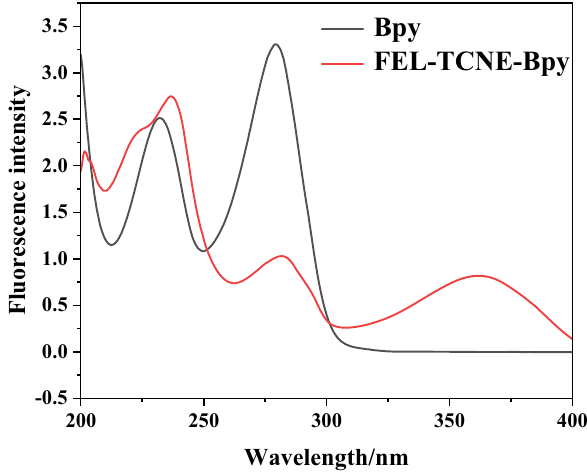
Figure 2: Ultraviolet absorption spectra of Bpy, FEL – tetracyanovinyl – Bpy.